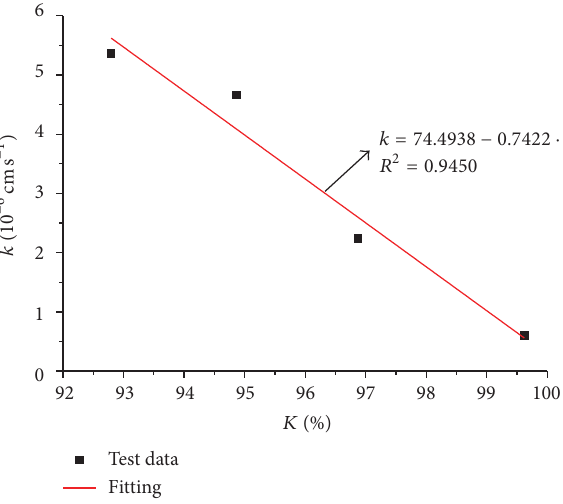
Figure 11: Relation between permeability coefficient 𝑘 and com- paction degree 𝐾